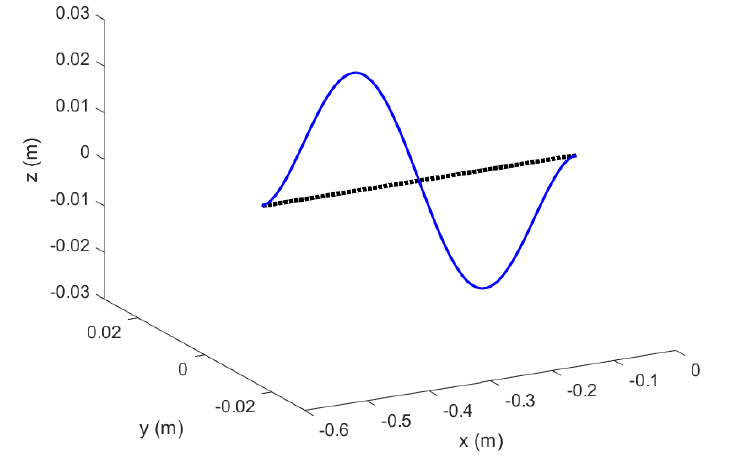
Figure 9. Mode 4 (in–plane/lead–lag) of two Euler–Bernoulli Beams connected through hinged